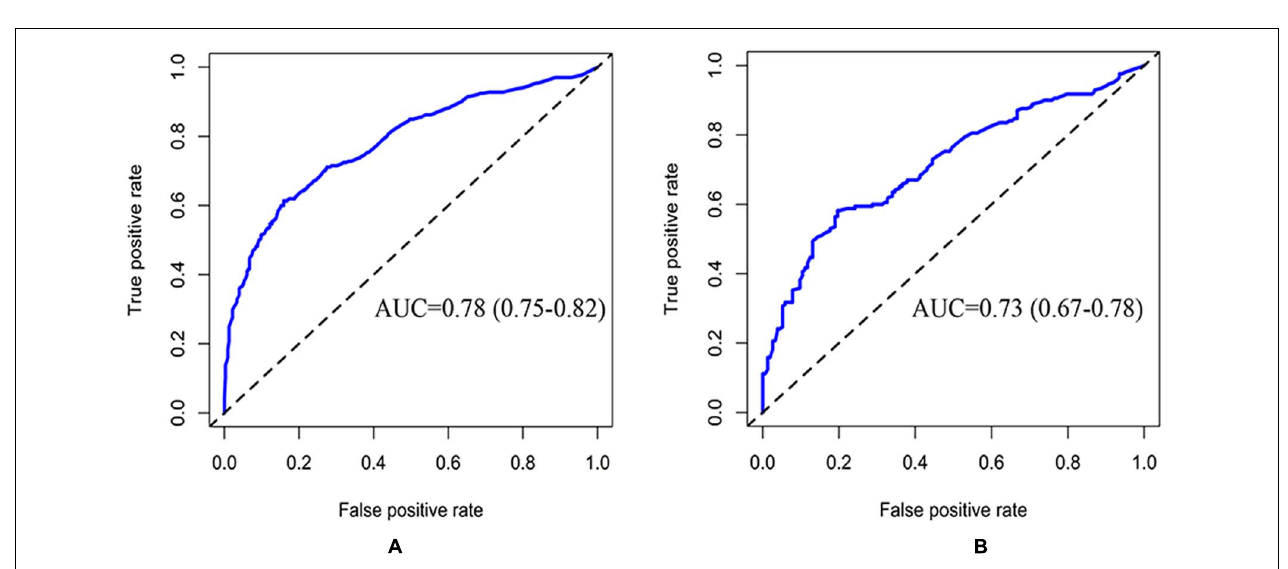
FIGURE 2 | ROC curve of training and testing cohort (Logistic Regression Model). Measurement of the discrimination ability of the caries risk prediction model (Logistic Regression) with ROC curve. The AUC (95%CI) of the training cohort was 0.70 (0.66–0.74) (A) , and the AUC (95% CI) of the testing cohort was 0.74 (0.68–0.79) (B)